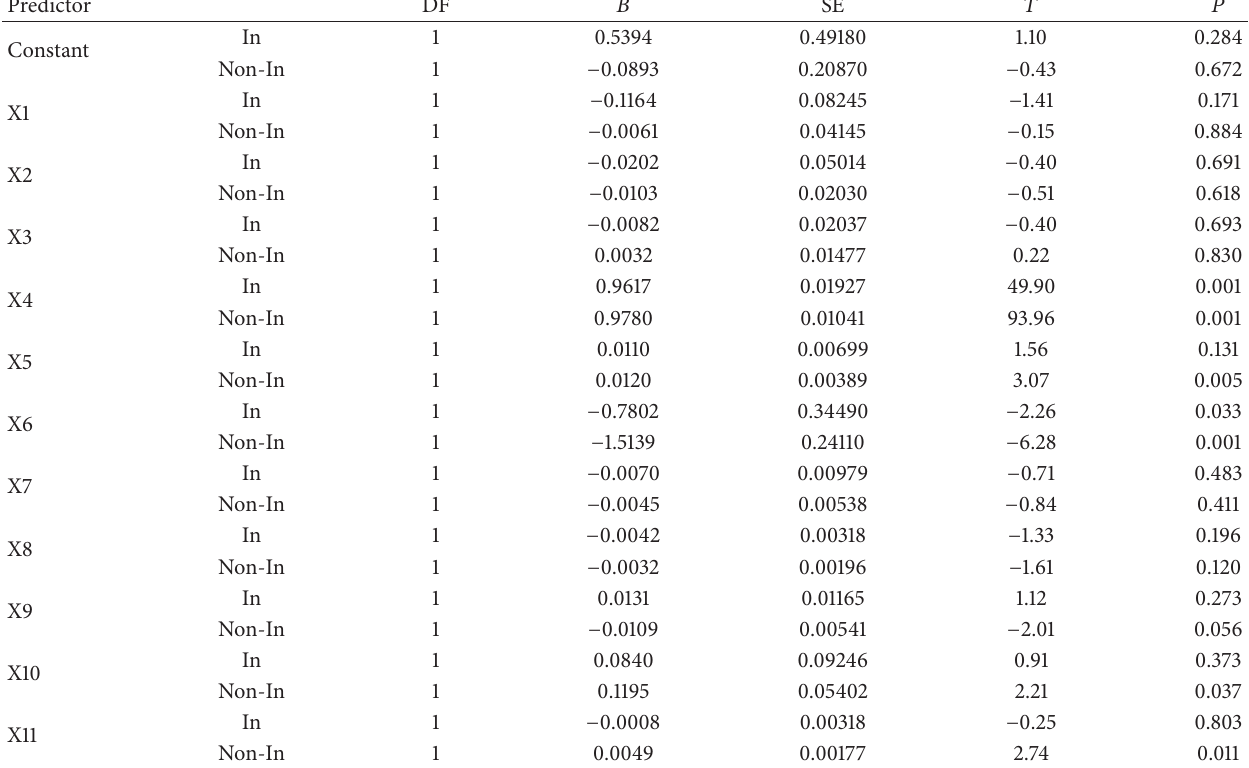
Table 5: The regression coefficient ( 𝐵 ), standard error (SE), 𝑇 value, and probability of the estimated variables in predicting wheat grain yield by the multiple linear regression analysis under inoculation (In) and noninoculation (non-In) conditions and different water levels.